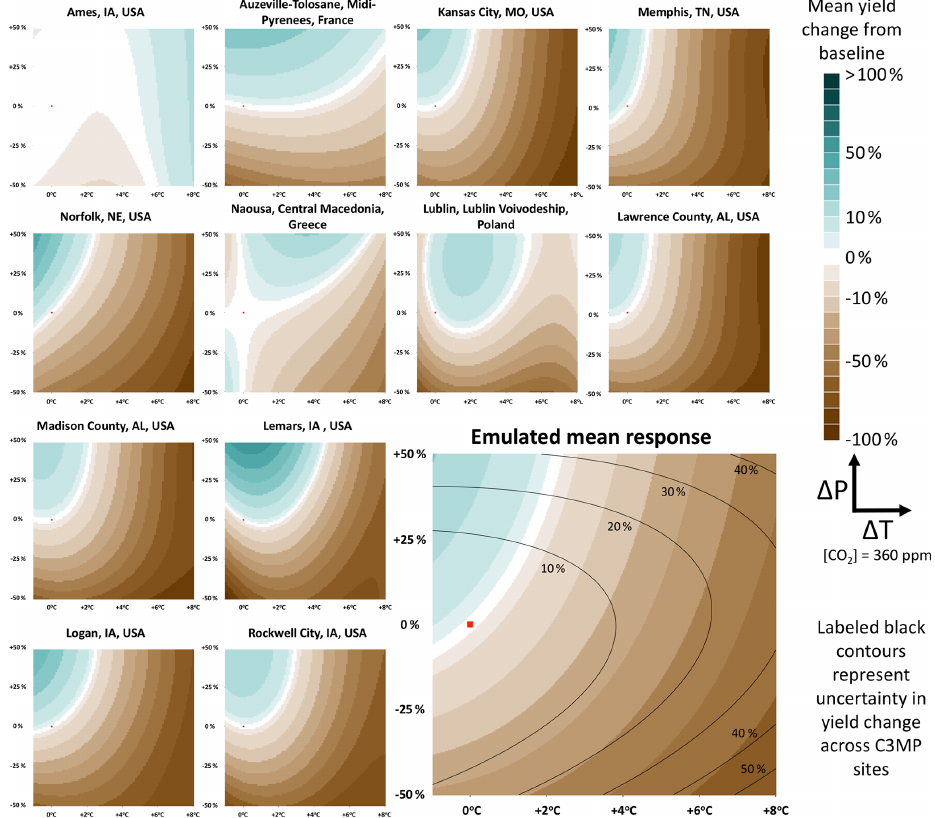
Figure 9. Yield responses to changes in temperature and precipitation with fixed [ CO 2 ]= 360ppm for 12 (of 66 total) rain-fed maize sites located in the midlatitudes, as well as the emulated mean response for use in